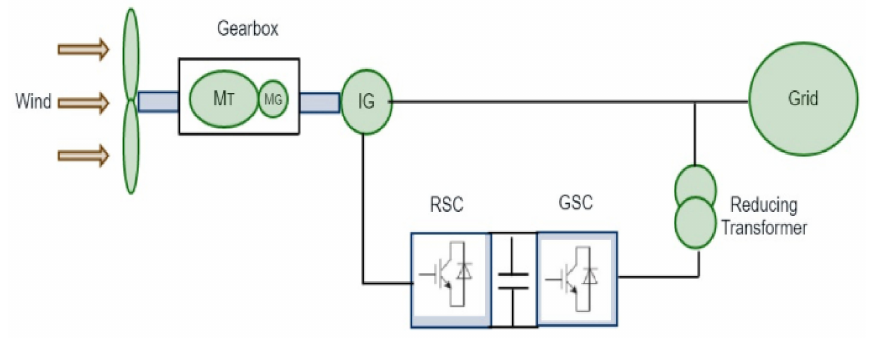
Figure 2. Single-line model of